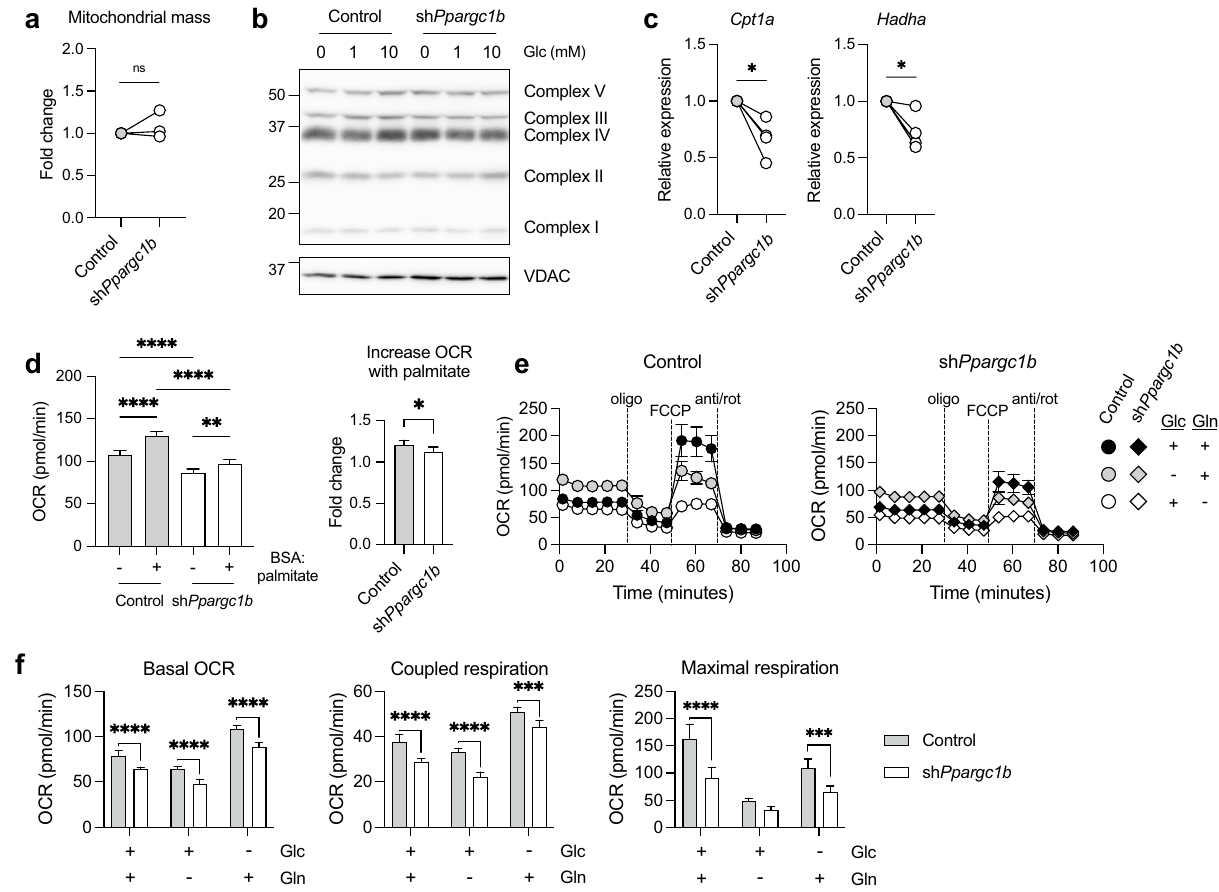
Figure 4. Impaired oxidative metabolism in PGC-1β-deficient DCs is not due to net changes in mitochondrial mass nor is it substrate-specific. DCs were transduced with control shRNA or Ppargc1b shRNA. ( a ) Mitochondrial mass of DCs stained with MitoSpy Green or MitoTracker Deep Red, with geometric MFIs represented as fold changes relative to the control condition. ( b ) Protein expression of complexes I-V of the ETC and VDAC of control or PGC-1β-deficient DCs cultured with 0, 1, or 10 mM glucose for 6 h. ( c ) Gene expression fold changes of Cpt1a (left) and Hadha (right) relative to Hprt . ( d ) DCs were cultured in nutrient- limiting media for 6 h and OCR was measured immediately following addition of either BSA or BSA-conjugated palmitate. ( e ) OCR was measured by Seahorse bioanalyzer over time with sequential treatments with oligomycin (oligo), FCCP, and antimycin and rotenone (anti/rot), in assay medium with or without 10 mM glucose or 2 mM glutamine. ( f ) Basal OCR, coupled respiration, and maximal respiration determined from the experiment in ( e ). Data from ( a , c ) are of ( a ) three and ( c ) four experiments pooled together, with each individual experiment represented by a circle and conditions from the same experiment joined by a line. Data from ( b ) is one experiment representative of three experiments. Data from ( d – f ) are of one experiment representative of two experiments (s.d. of five to six replicates per condition). Statistical significance was determined by ( a , c ) paired t -test, ( d , left) one-way ANOVA, ( d , right) unpaired t -test, or ( e , g ) two-way ANOVA. *p < 0.05, **p < 0.01, ***p < 0.001, ****p <